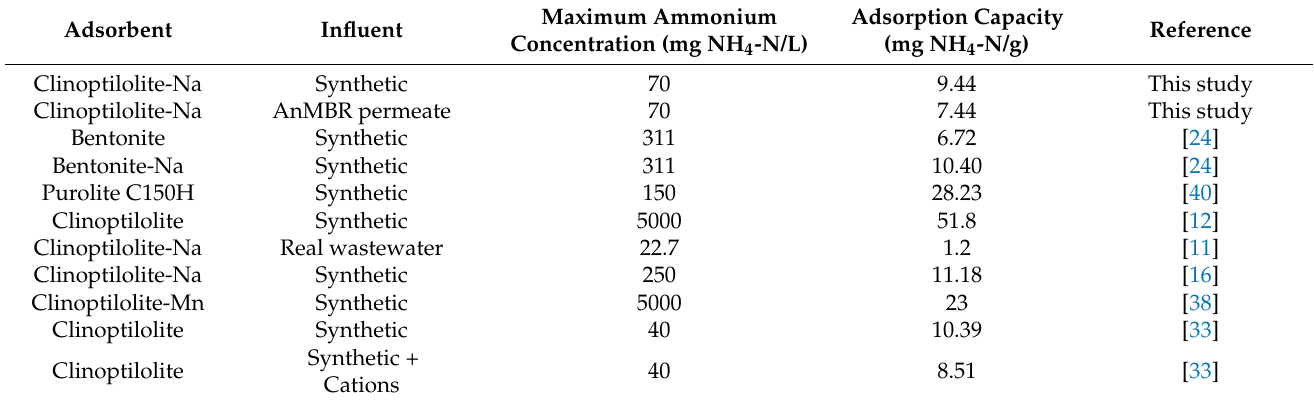
Table 6. Comparison of adsorption capacity ( q e ) by different adsorbents and ammonium